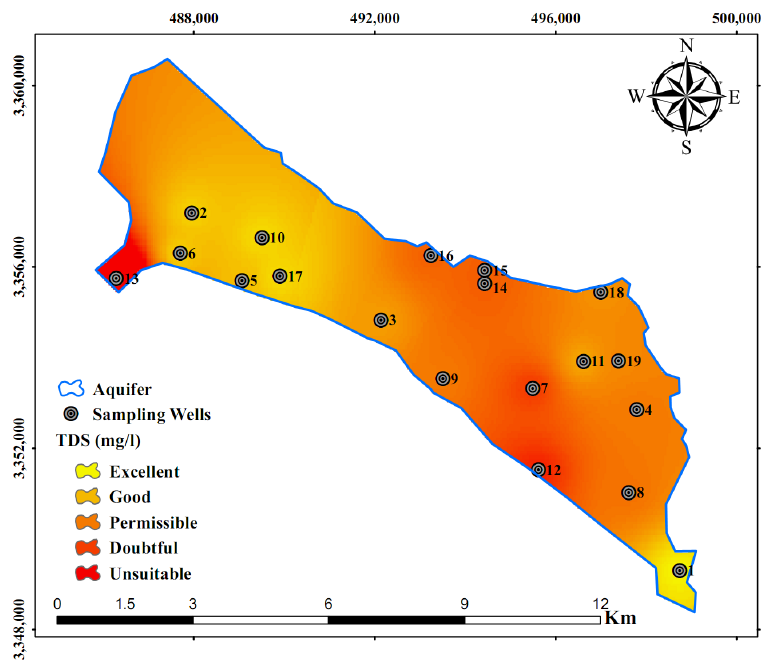
Figure 5. Spatial distribution of total dissolved solids (TDS) in the study area.